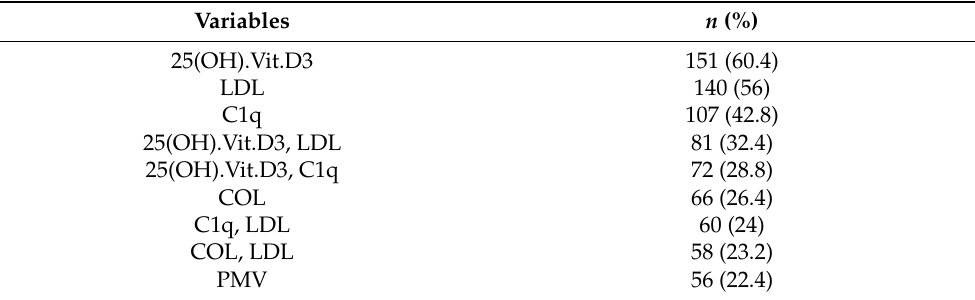
Table 4. Top blood analytic variables showing abnormal values with respect to reference values in our cohort ( n = 250). The number of cases with abnormal values with respect to reference values and percentages (%) are